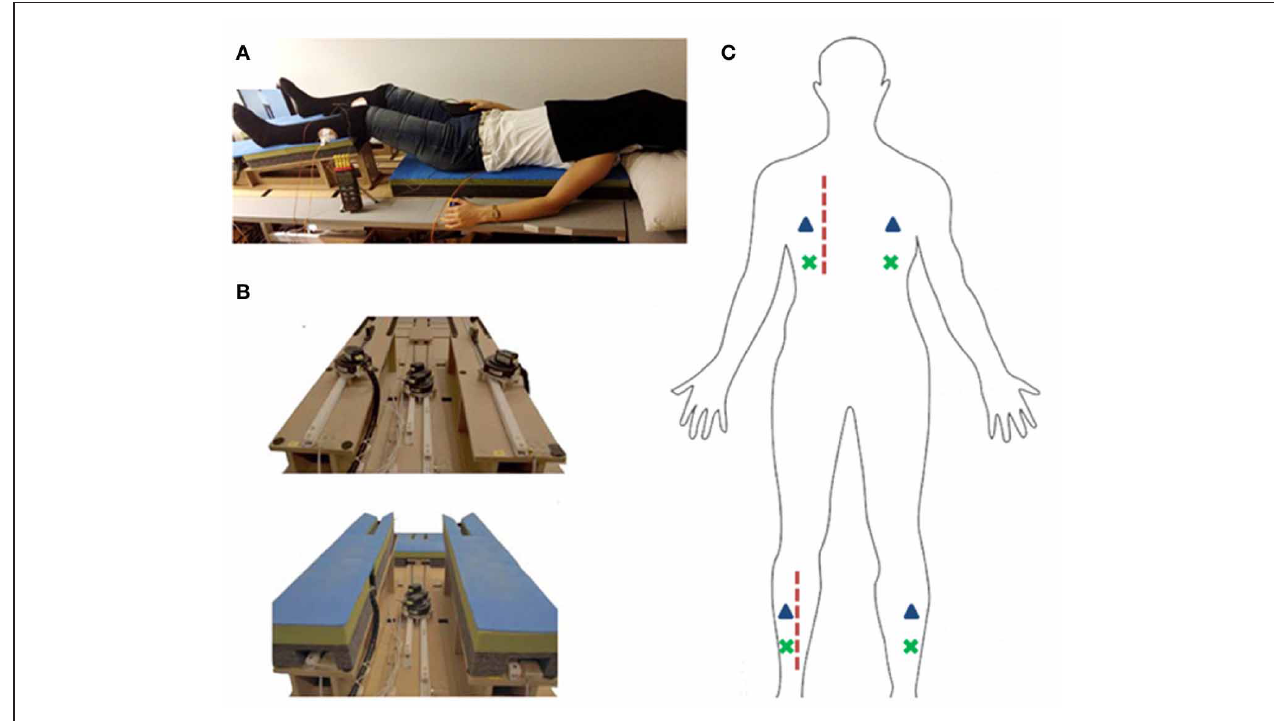
FIGURE 1 | Experimental setup. (A) Picture of experimental setup. Participant lying on robotic stroking device. (B) Robotic stoking device shown from feet perspective. Top: padding removed for motor view. Bottom: robot